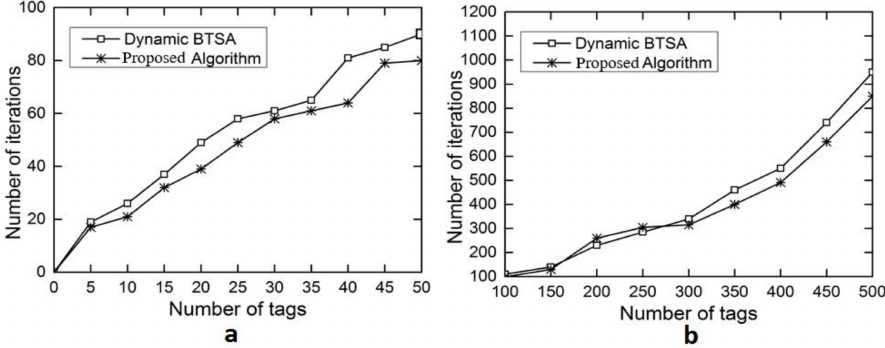
Figure 6. Comparison on the number of iterations between DAF-OS and DBTSA. ( a ) Number of tags in the range 5–50; ( b ) number of tags in the range 100–500.